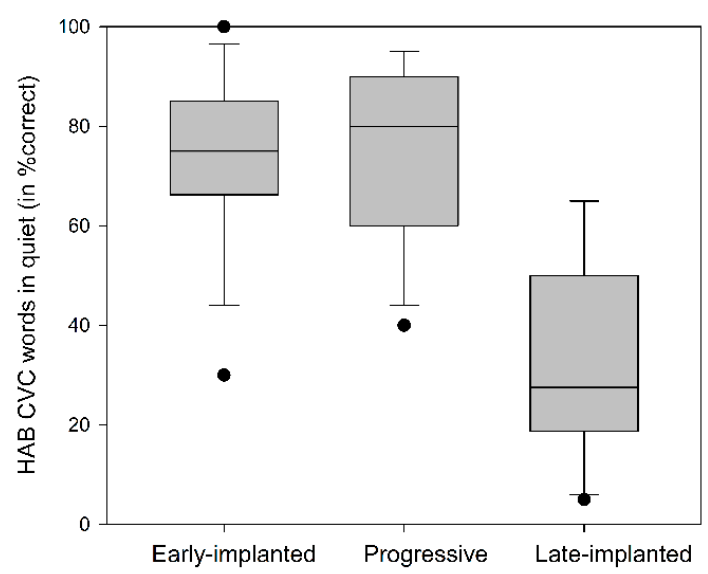
Figure 3. Box-and-whisker plot of the results in the Hebrew Arthur Boothroyd (AB) consonant– vowel–consonant (CVC) words in quiet (HAB) test for the early-implanted ( n = 16), progressive ( n = 13), and late-implanted ( n = 10) CI users.